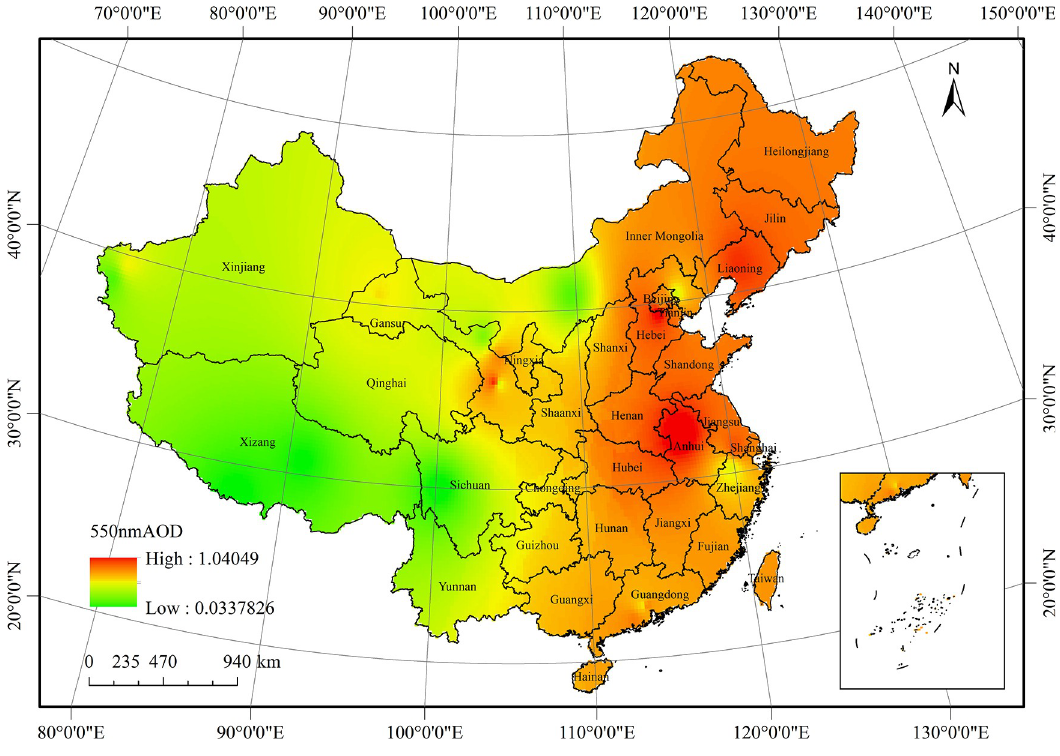
Fig 3. Average distribution of 550 nm AOD in China from 2005 to